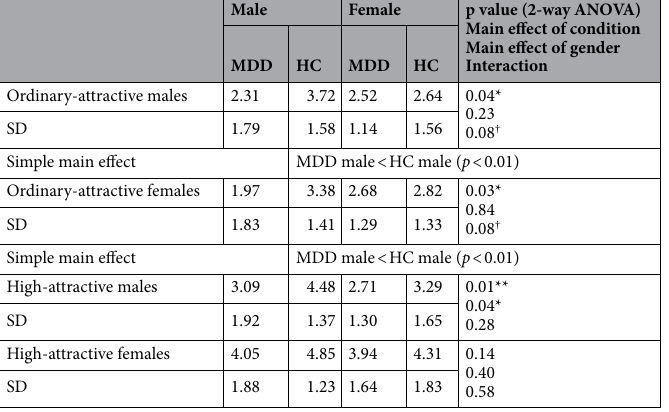
Table 3. Preference score for each type of photographed partner. † p < 0.10, * p < 0.05, ** p <